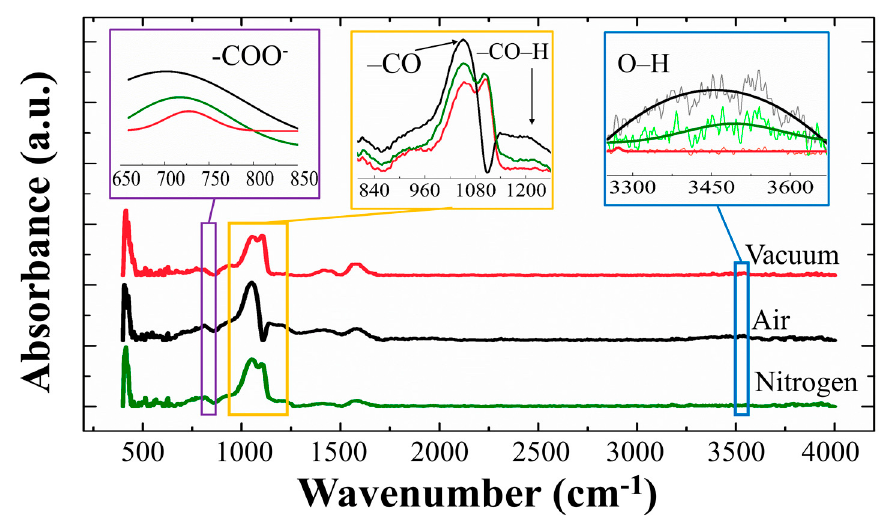
Figure 9. Fourier transform infrared (FT-IR) spectra of ZnO SLs annealed in vacuum, air, and N 2 ambients. Inset shows an enlarged view of the spectra in a wave number range of 650–850, 800–1250, and 3250–3650 cm − 1 .